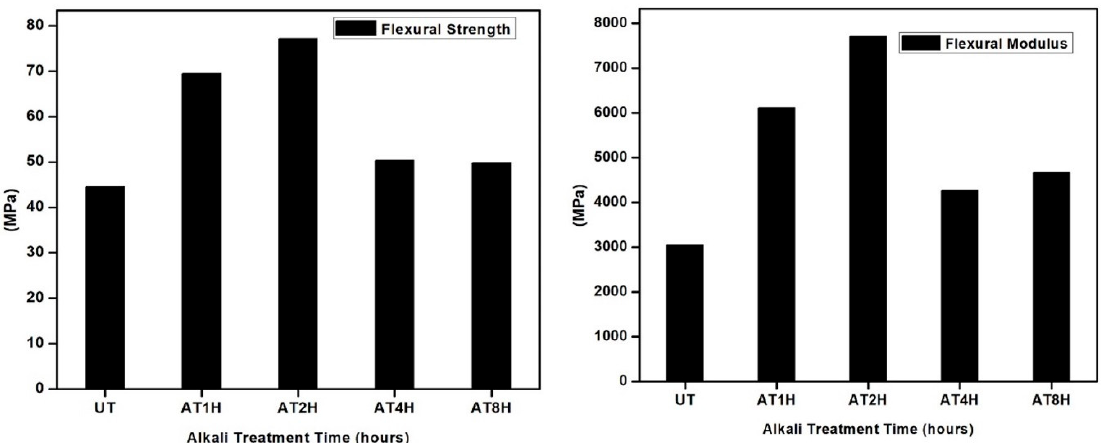
Figure 4. Flexural and Modulus Elasticity of untreated and treated Typha fiber reinforced epoxy composite.